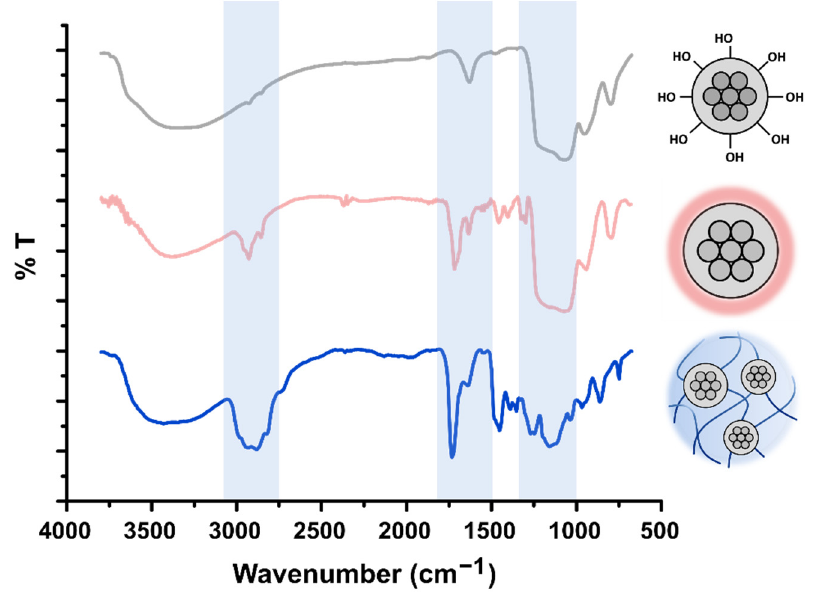
Figure 3. FT-IR spectra of pristine MSNs, functionalized MSNs (MSN@MEMO), and HNGs in water (HNG-P(DEGMA)).